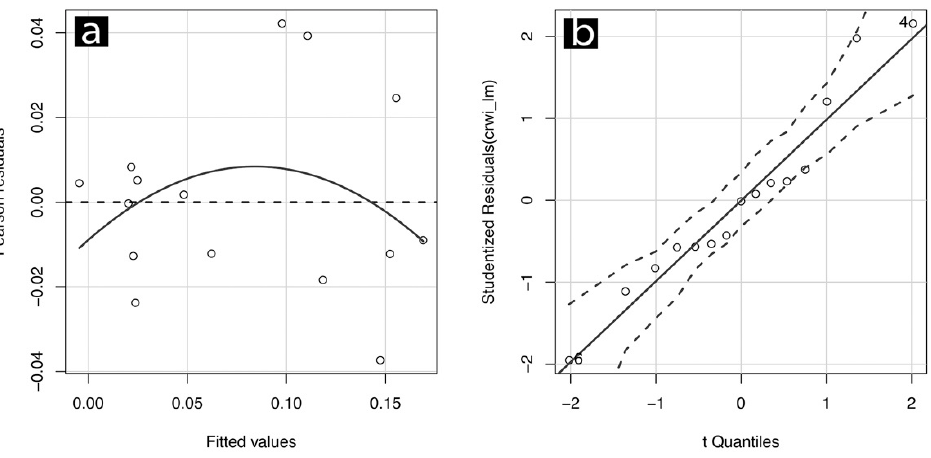
Figure 14. ( a ) Scale-location plot and ( b ) QQ-plot for the CRWI-net GWC predictive model. This ground-sample/air-borne measurement range mis-match is similar to the well- known challenges of validating large-footprint satellite soil moisture sensors (e.g., microwave-based) using point-based measurements of soil moisture (e.g., [41]). As shown above, ground-truth sampling at length scales approximating the spatial resolution of the airborne reflectance sensor (5 m distance between samples with ~2 m sensor footprint and ~1 m gridding) produce a CRWI-net GWC function that shows little systematic bias, but does suffer from the shortcoming that it does not reflect the full range of CRWI index